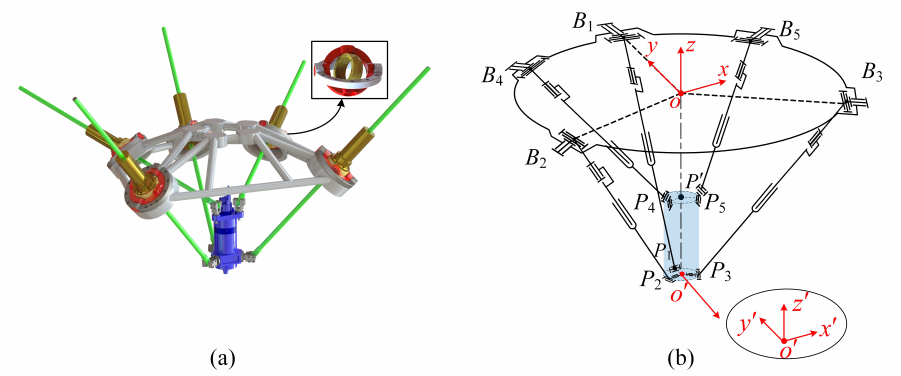
Figure 1. Geometric model of the proposed spatial PM with 5-DoF: ( a ) CAD model and ( b ) kine- matic